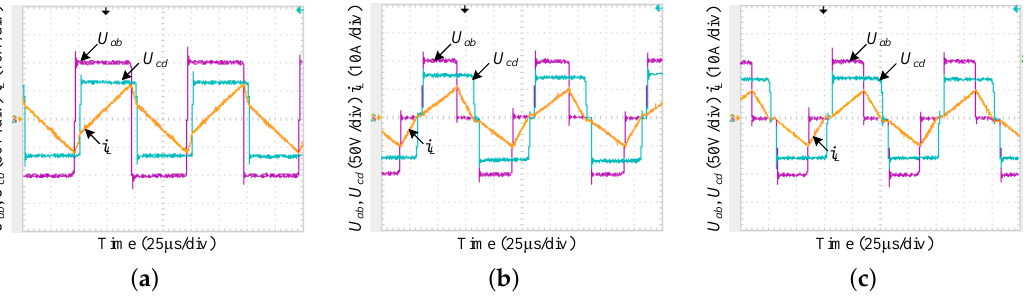
Figure 15. Experimental waveforms of DAB converter with M min = 0.04, k = 1.5, U 1 = 100 V, P = 300 W: ( a ) single-phase-shift (SPS) scheme; ( b ) unified triple-phase-shift (UTPS) scheme; and ( c ) TPSiDT